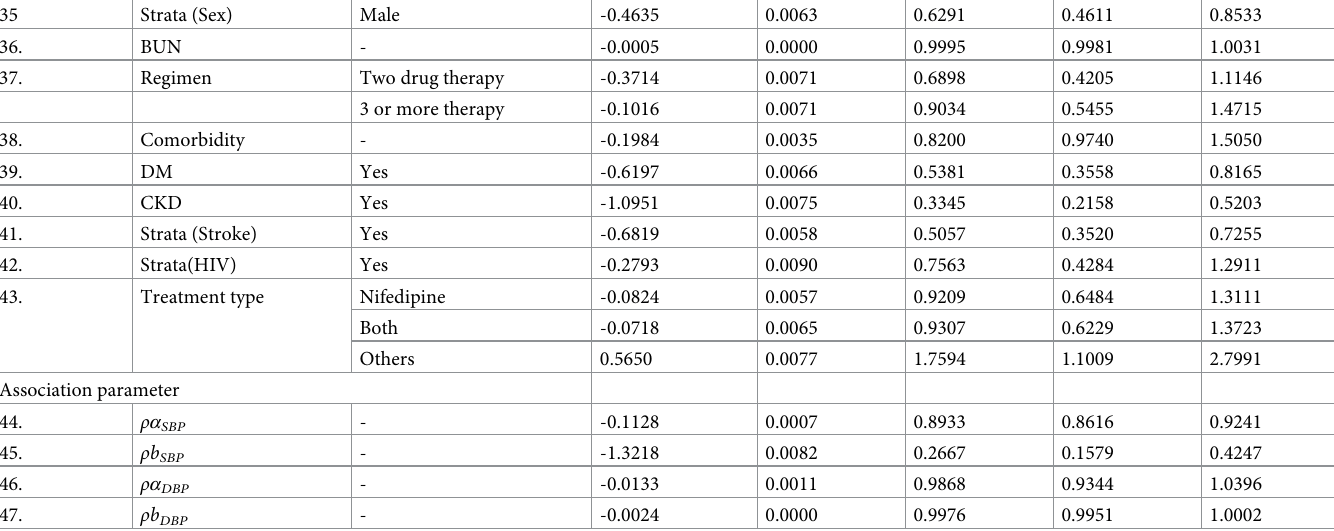
Key: ρ α SBP and ρ b SBP the association parameter for the current true value and slope of SBP respectively; ρ α DBP and ρ b DBP the association parameter for the current true value and slope of DBP respectively. α i and bi corresponds with random intercept and random